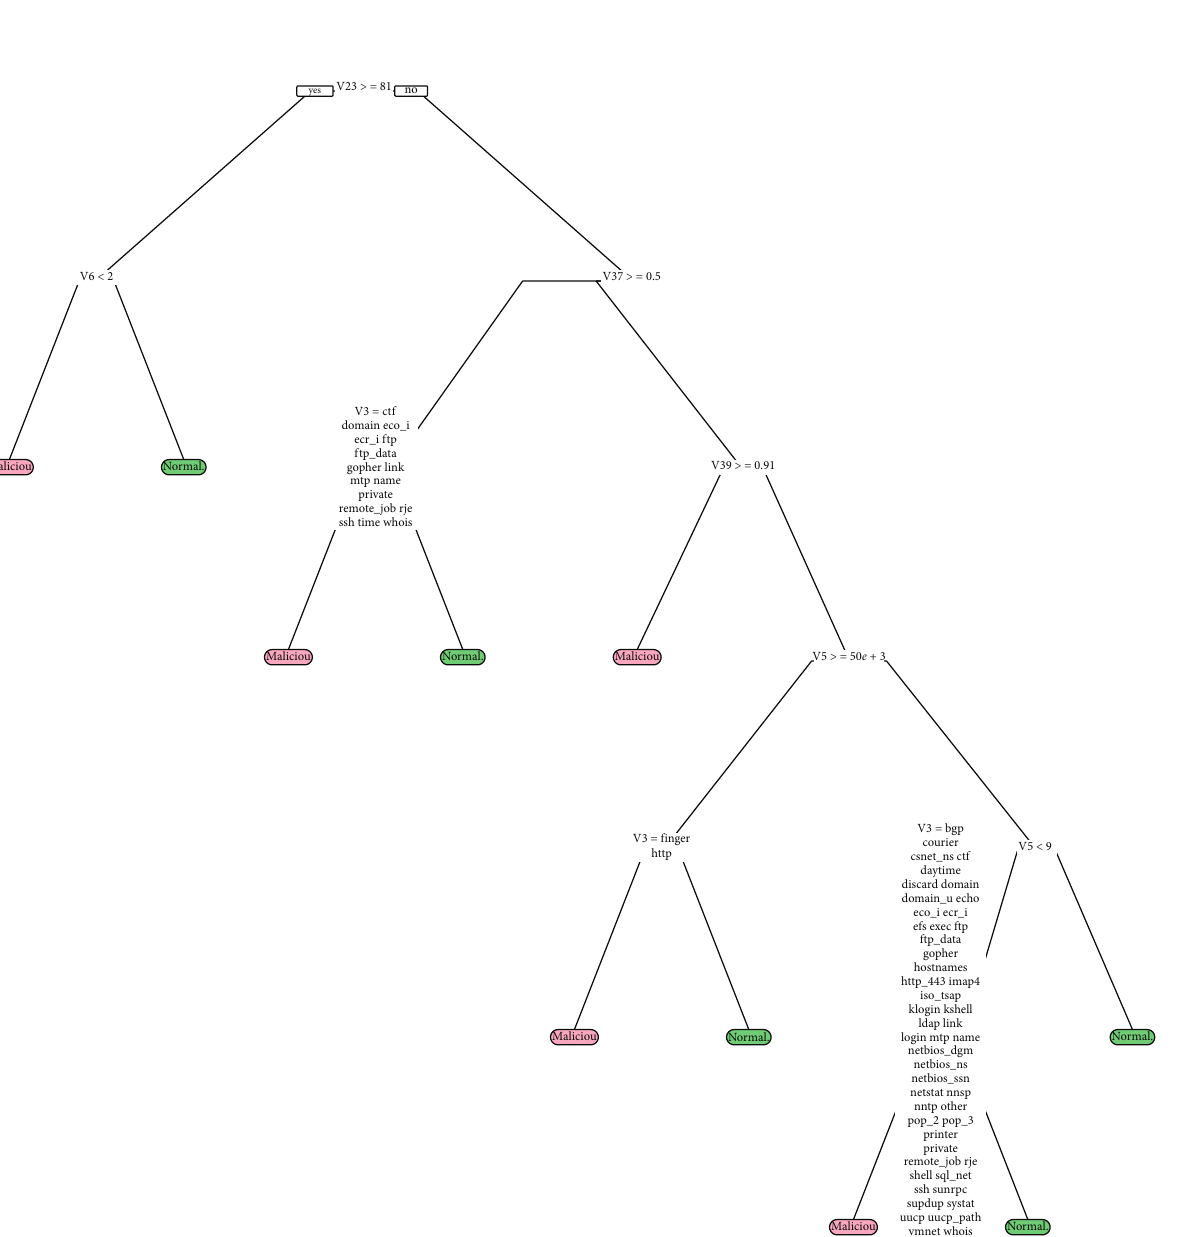
Figure 3: Decision tree from the training dataset. Pink nodes are malicious nodes, and green nodes are normal nodes.